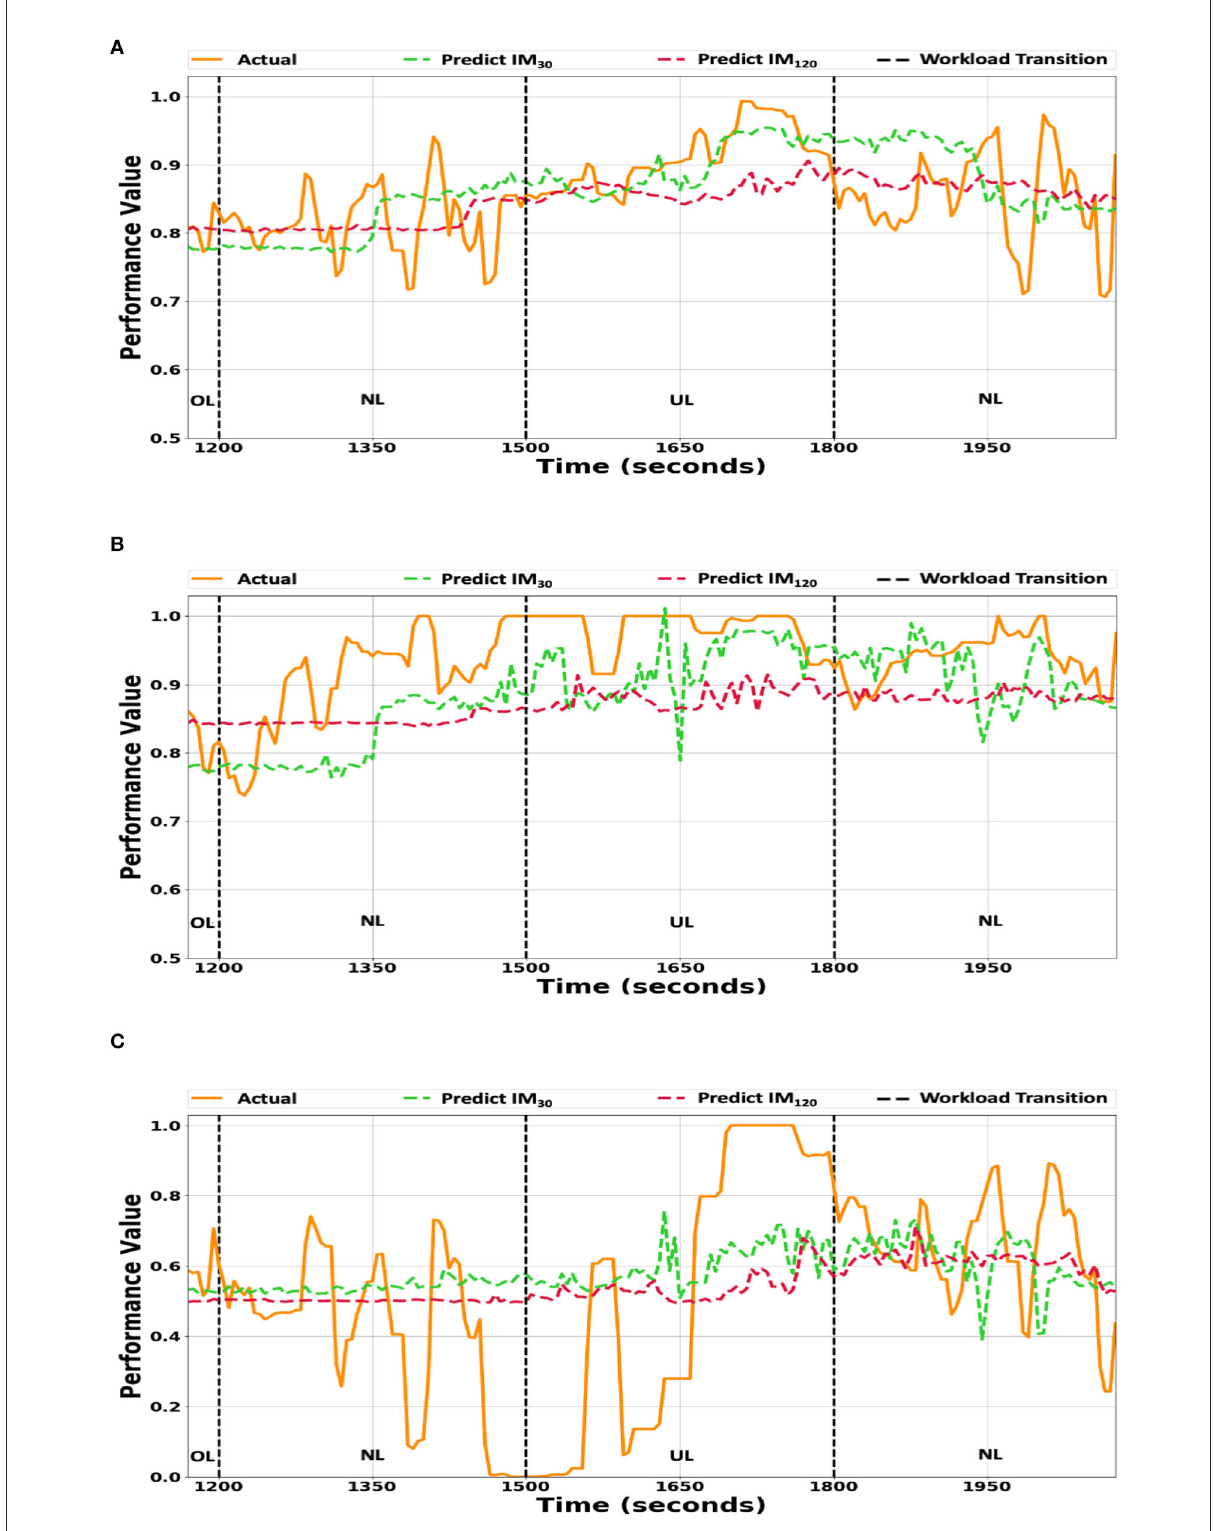
FIGURE3 (A) The individualized model predictions vs. the averaged participants’ true performance values. (B) The individualized model predictions vs. the true performance values of participant P best . (C) The individualized model predictions vs. the true performance values of participant P worst . The IM 30 and IM 120 prediction model variant’s predictions plotted against the true performance values for workload ordering O 2 . The y-axis scale ranges from 0.5 to 1.0 for (A,B) , while for (C) , it ranges from 0.0 to 1.0. UL/NL/OL in the plots represent the workload